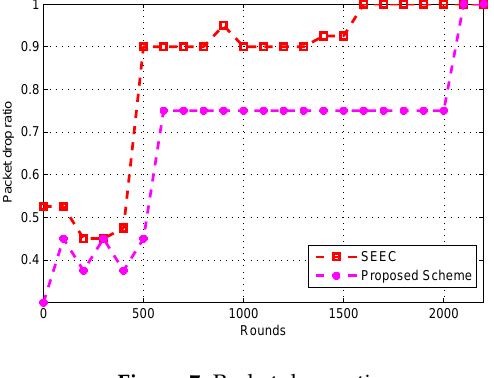
Figure 7. Packet drop